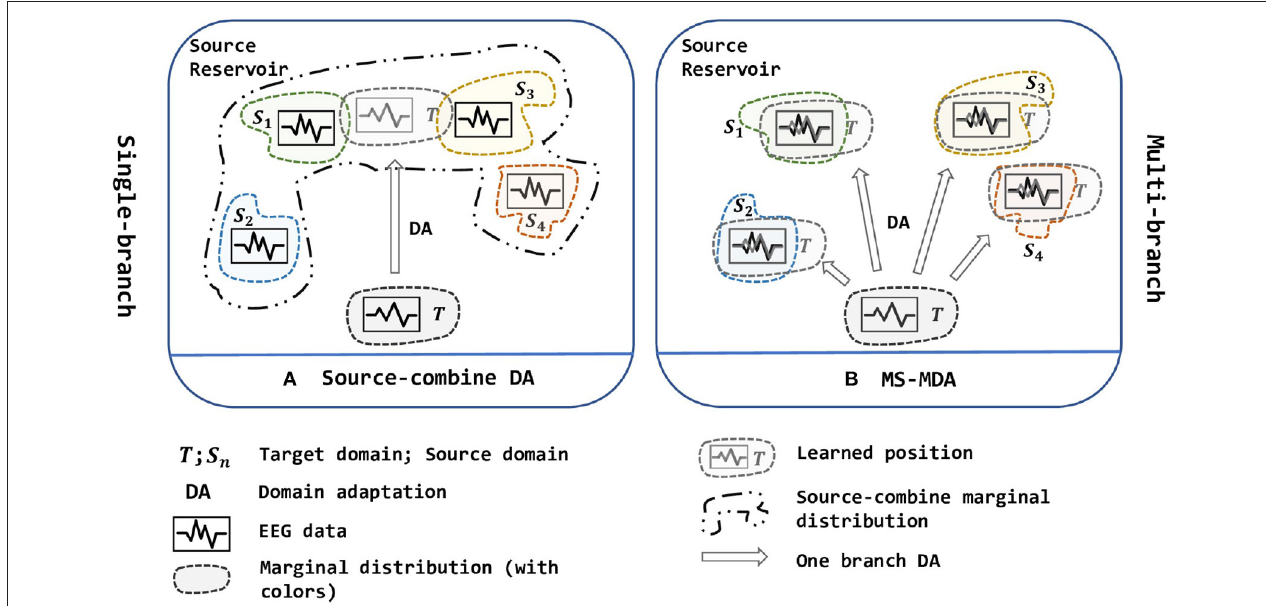
FIGURE 1 | Two strategies of multi-source domain adaptation. (A) is a single-branch strategy while (B) is a multi-branch strategy. In (A) , all source domains are combined into one new big source and then been used to align distribution with the target domain, while in (B) , multiple sources are being aligned at the same time, and are divided into multiple branches to adopt DA with the target domain. In short, (A) is one source, one branch with one-to-one DA; (B) is multiple sources, multiple branches with one-to-one DA. The figure is best viewed in